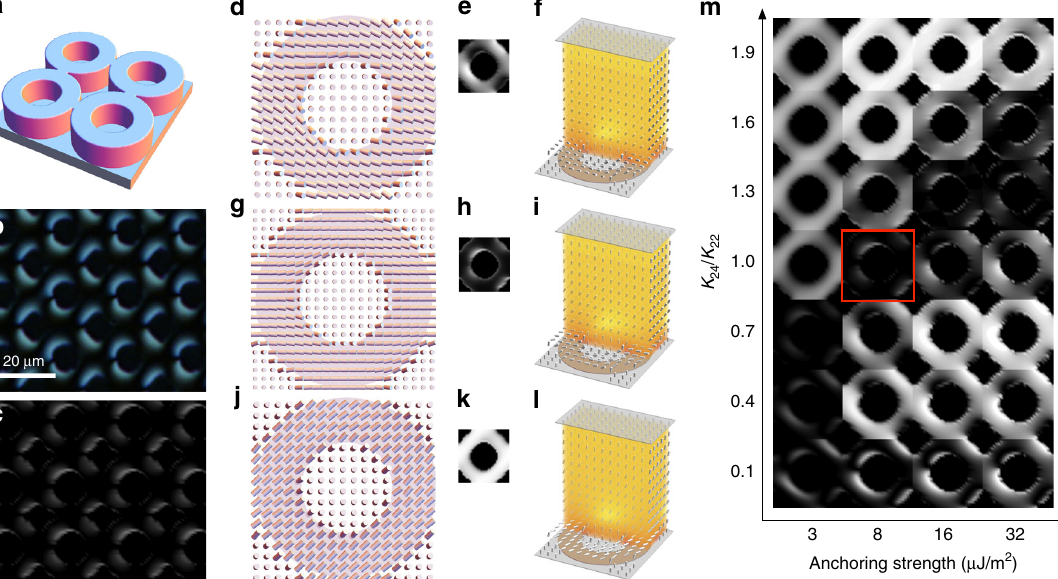
Fig. 5 Periodic annular posts. a Schematic of annuli pattern, showing several periods. b Experimental observation and c simulation of 5CB on an array of touching annuli. An extended array of − 1/2 defects forms and breaks the pattern symmetry. d – l Calculated director pro fi les ( d , g , j ) at the top of post, ( e , h , k ) simulated POM images and ( f , i , l ) director pro fi les throughout the the cell for W = 8 μ J/m 2 and d – f K 24 = K 22 ¼ 0 : 7, g – i K 24 = K 22 ¼ 1 (the value that best agrees with experiment) and j – l K 24 = K 22 ¼ 1 : 9. m Simulated microscope images of 5CB on periodic annular posts as a function of saddle-splay constant K = K and surface anchoring strength. The parameter pairing that best agrees with experiment is highlighted with a red box 24 22